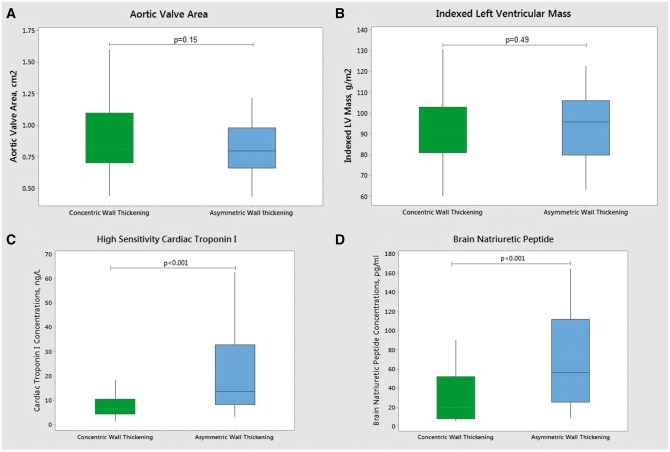
Characteristics of patients with asymmetric vs. concentric wall thickening. Boxplots presenting: aortic valve area (A), indexed left ventricular mass (B), high sensitivity cardiac troponin I (C) and brain natriuretic peptide (D) concentrations in aortic stenosis patients with asymmetric and concentric patterns of wall thickening. Despite no difference in AVA and left ventricular mass index (P = 0.15 and P = 0.49, respectively) patients with asymmetric wall thickening had higher cardiac troponin and BNP levels than those with concentric wall thickening (P < 0.001).